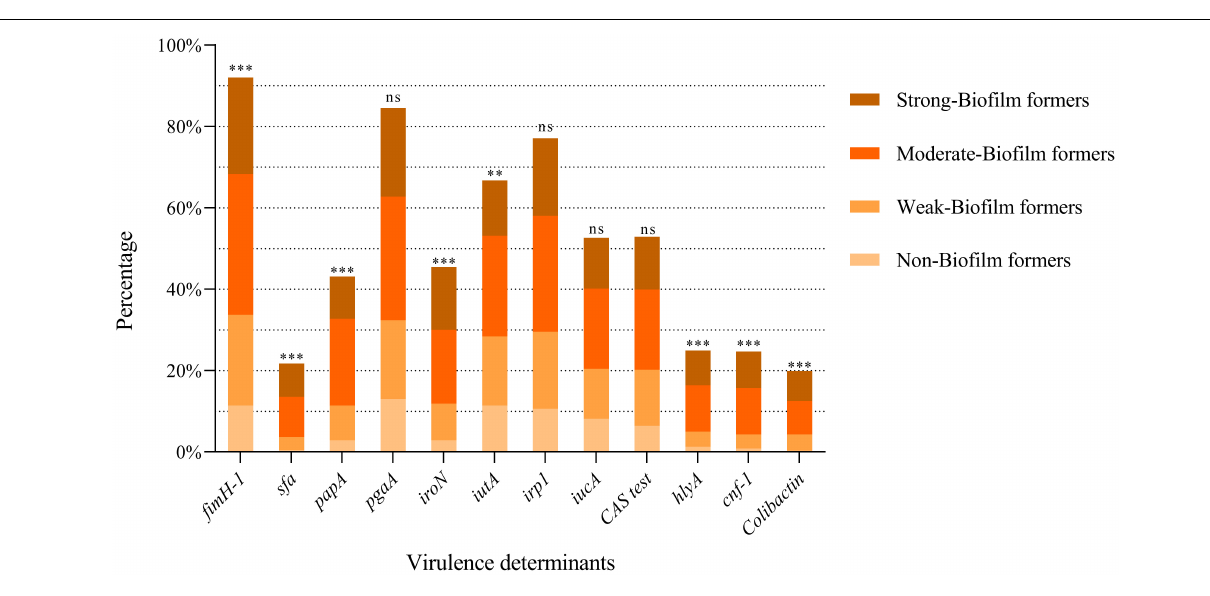
FIGURE 5 | Prevalence of the different VFGs tested according to the biofilm formation ability. Each bar shows the percentage of positivity of each gene within the total strains studied. Within each bar, the percentage according to the ability to form biofilms is shown. ∗∗∗ p < 0.001; ∗∗ p = 0.01; ns: not significant ( p >